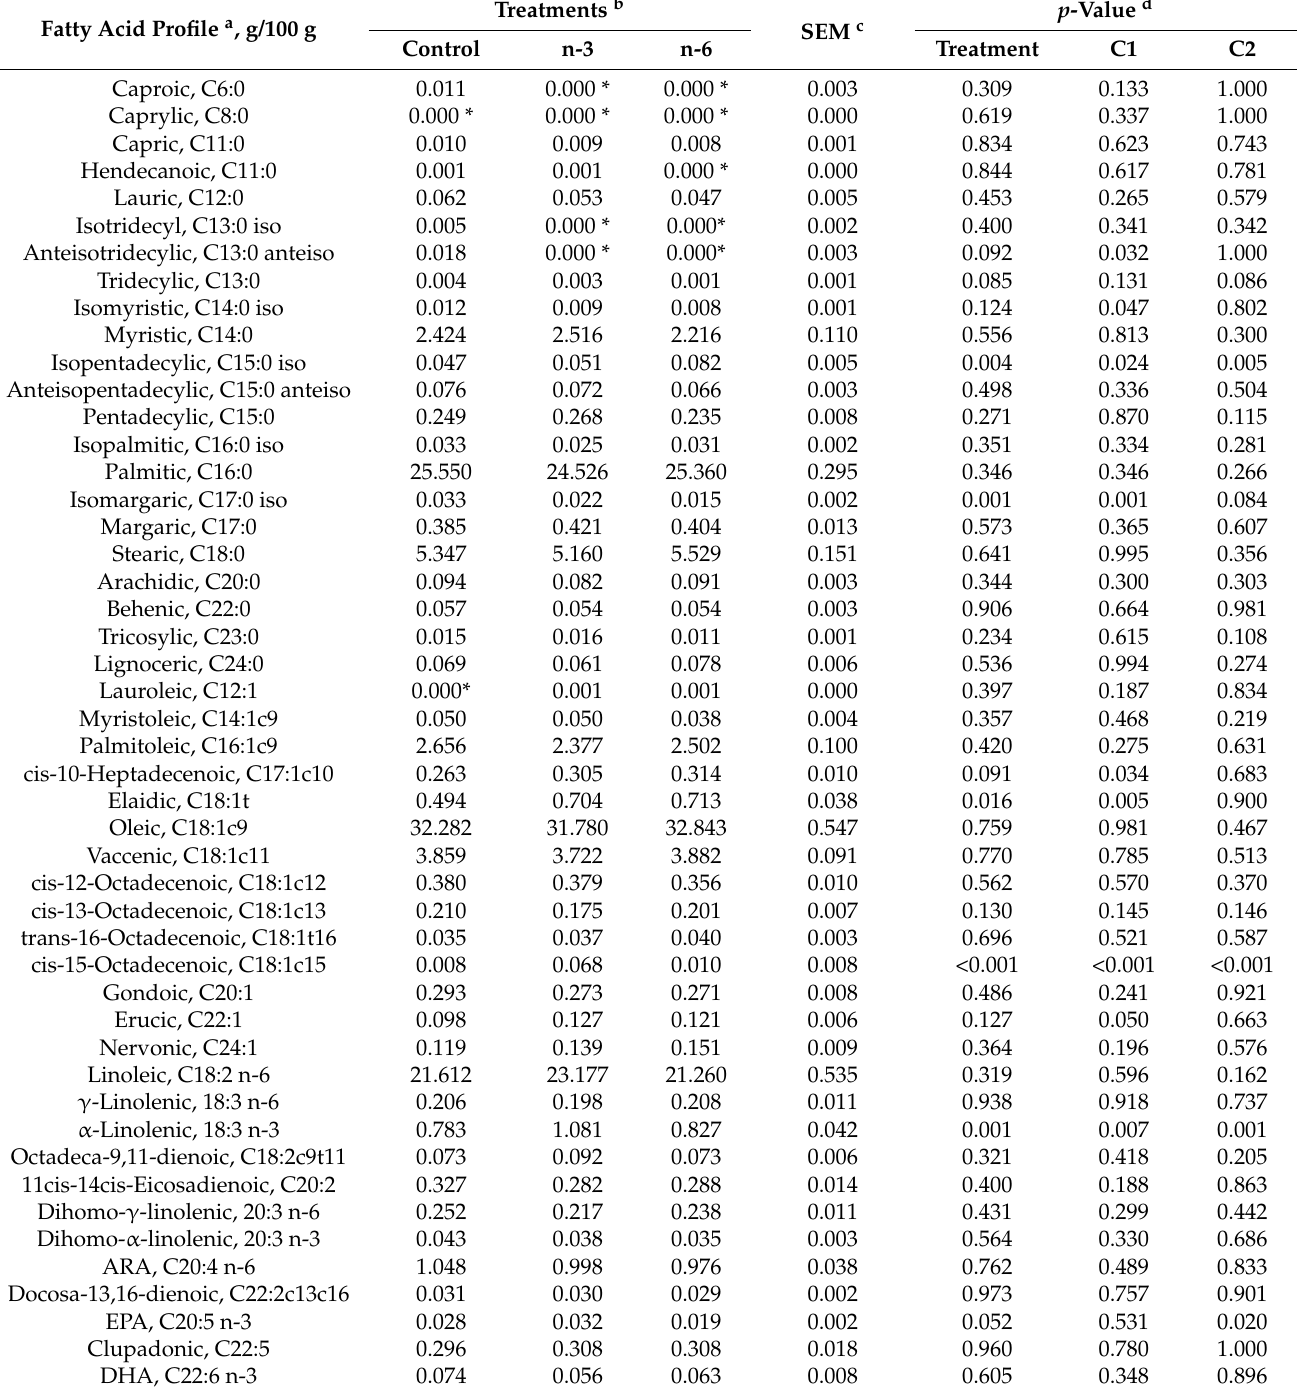
Table 7. Effect of supplementation of milk enriched with n-3 and n-6 on the fatty acid profile of sows’ colostrum. Fatty Acid Profile a , g/100